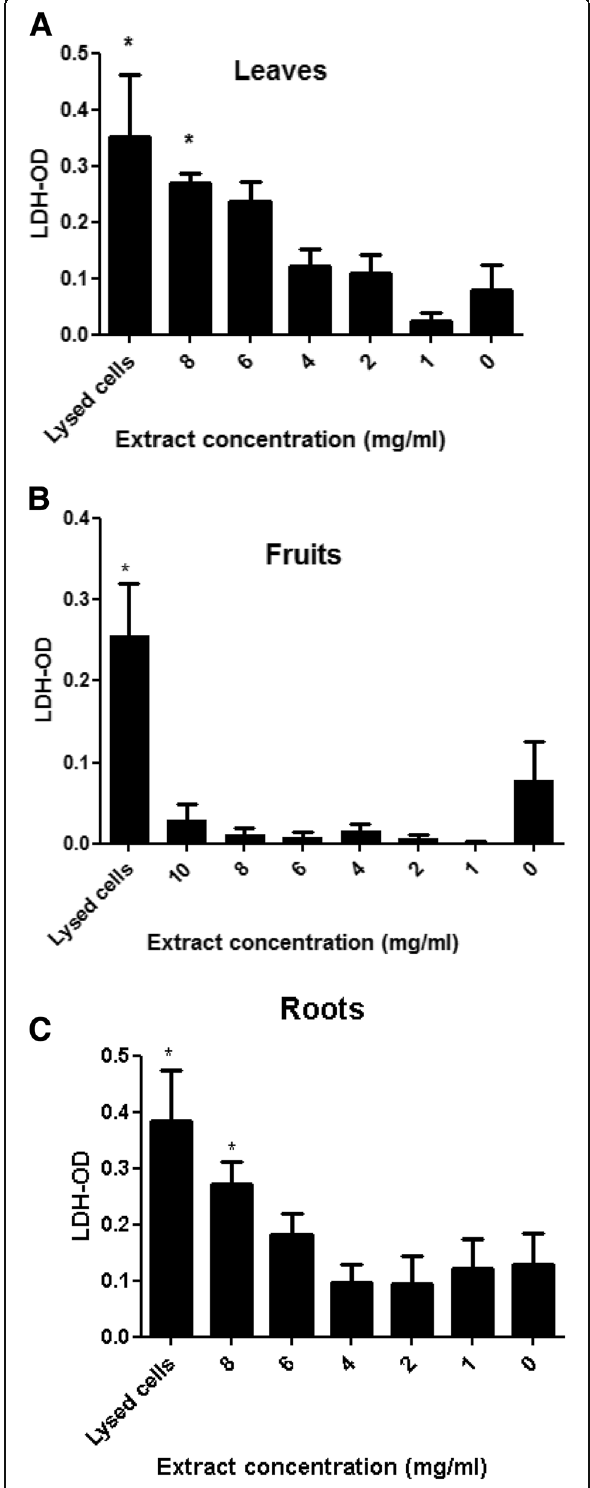
Fig. 1 LDH release following treatment with S. spinosum extracts in 3 T3-L1 preadipocytes. Cells were cultured on a 96-well plate, at a concentration of 1 × 10 5 cells/ml in the absence or presence of different concentrations of S. spinosum extracts ( a . leaves, b . fruits, c roots). LDH was measured in the culture media as described in the Materials and Methods . Results are mean ± SEM of 3 independent